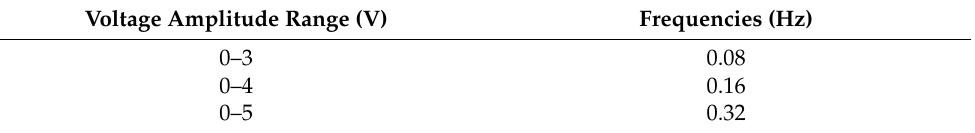
Table 2. The input voltage parameters that the generalized model was based on.